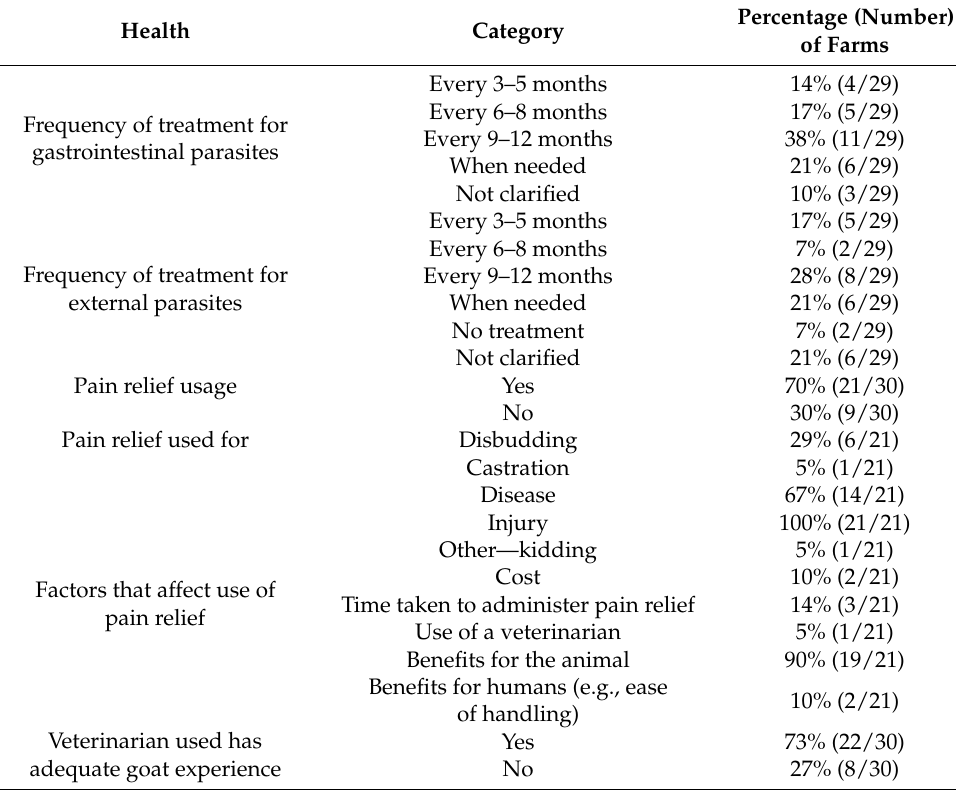
Table 4. Dairy goat producer responses relating to routine health practices.